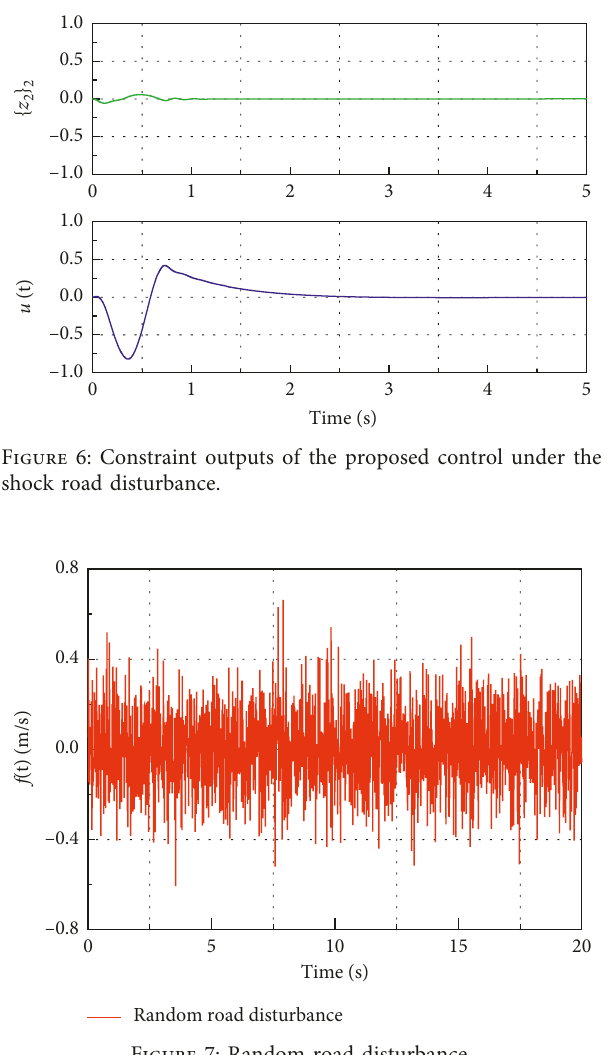
Figure 7: Random road disturbance.